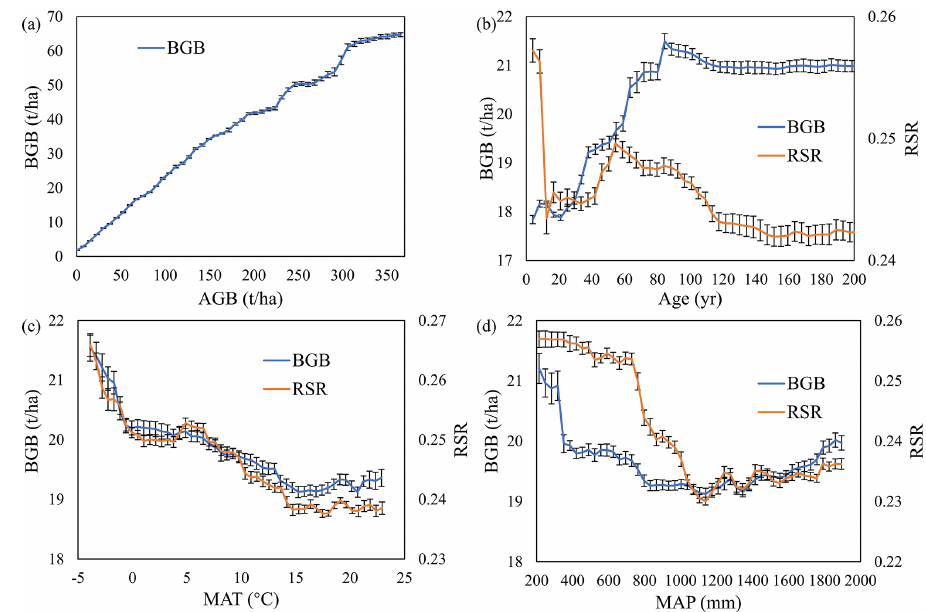
Figure 4. Influence of key factors on forest belowground biomass (BGB) and root–shoot ratio (RSR) in China. Subfigures (a–d) show partial influences of (a) AGB, (b) stand age, (c) MAT and (d) MAP on BGB and RSR values of all forest plots. The error bars represent the standard deviations of the 10-fold training. We did not draw the PDP for the impact of AGB on RSR, since the dividend of RSR calculation is AGB.